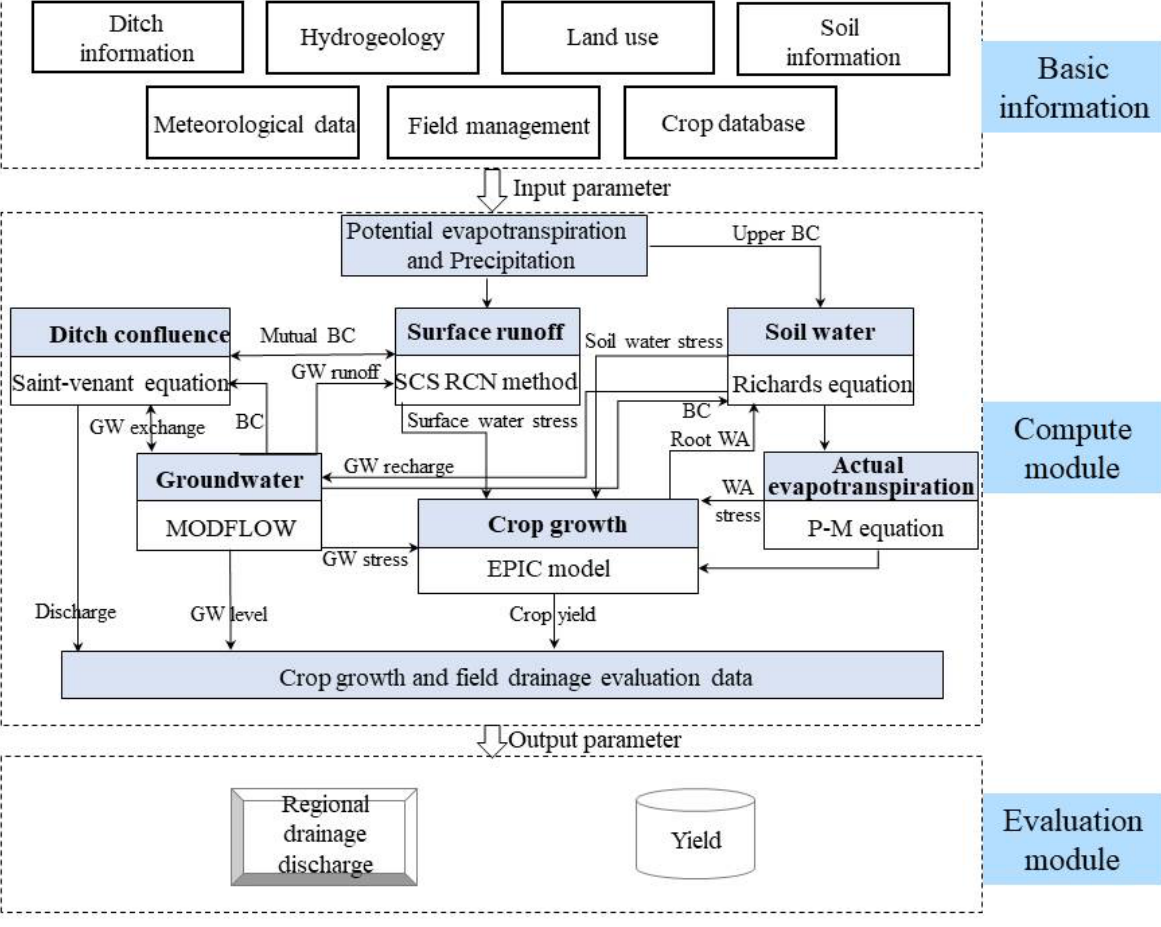
Figure 2. The frame diagram of ODCDCYSM. BC: boundary condition; GW: groundwater; RCN: runoff curve number; WA: water absorption; P-M: Penman–Montes.